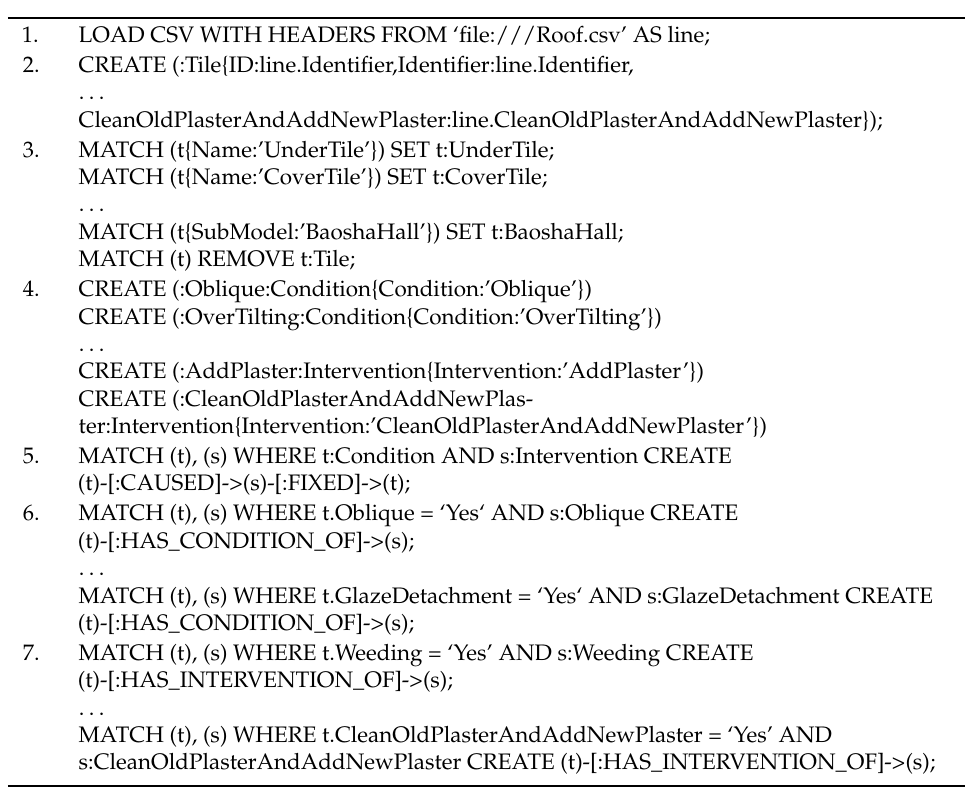
Figure 9. Preview of the entire roof in the Rhino viewport. Table 3. Import metadata repository to the graph